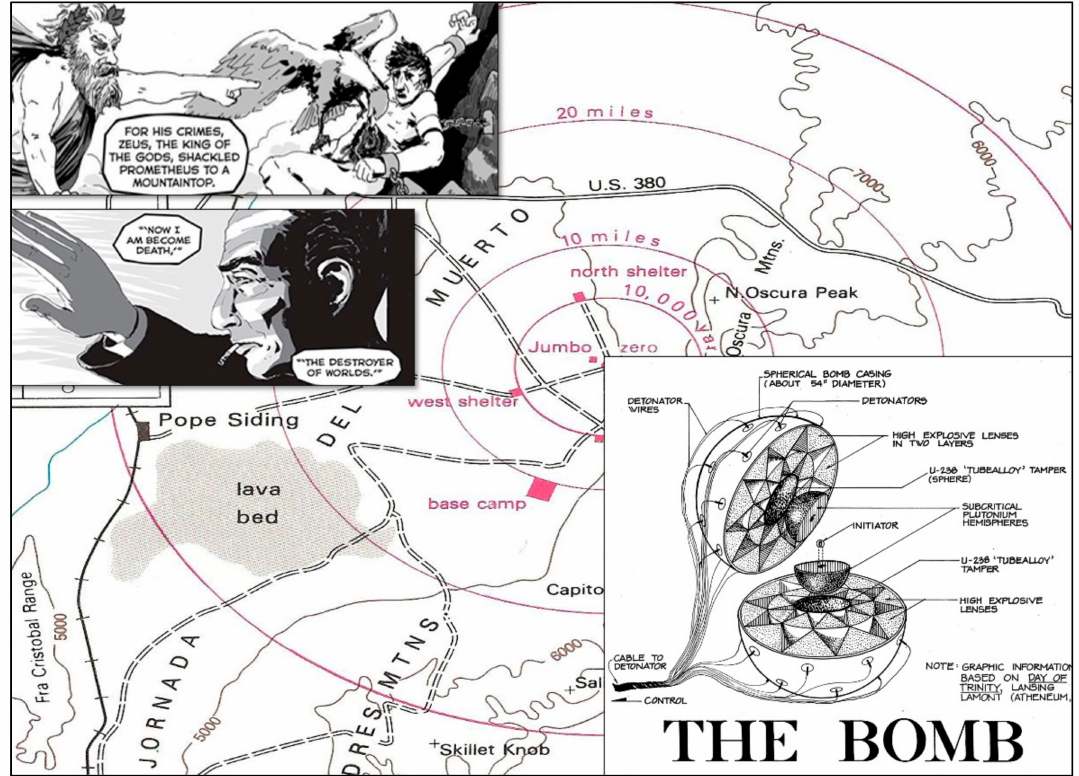
Figure 3. Historiophoty Bricolage Map of the Trinity Test Site in the Jornada Del Muerto desert of New Mexico, U.S.A. Sources: Jones, Manhattan: The Army and the Bomb (1985) p. 479; White Sands Missile Range, Trinity Site, Vicinity of Routes 13 and 20, White Sands, Dona Ana County, NM. Library of Congress. (Wikicommons) Review of Jonathan Fetter-Vorm’s Trinity: A Graphic History of the First Atomic Bomb : The Appendix , The End? December 2012-Vol. 1. No. 1. <http://theappendix.net/issues/2012/12/not-so-funny-pages-excerpt-trinity-a-graphic-history-of-the-first-atomic- bomb>; Berkun, S., Trinity (Review) 28 June 2012 <https://scottberkun.com/2012/trinity-a-graphic-history-of-the-atomic-